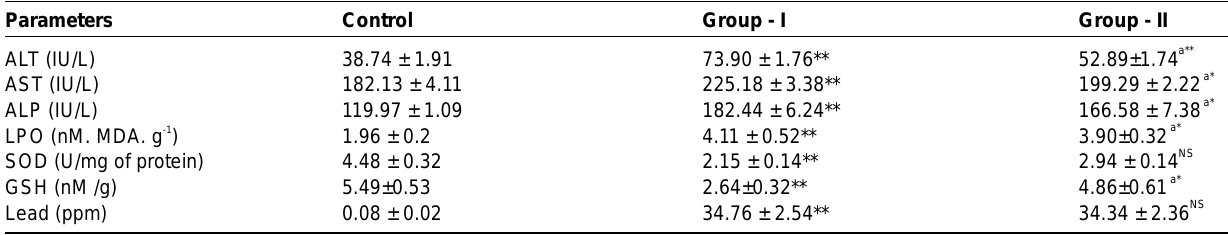
Table-1. Effect of lead alone and with Curcuma longa on various parameters. (Mean ± SEM)